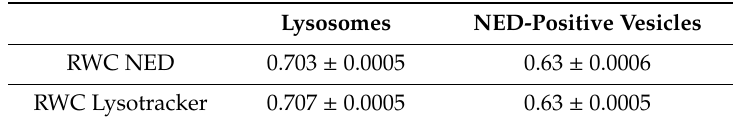
Figure 2. Live-cell imaging of cis -NED 19 localization in rat aorta smooth muscle cells. A —ER tracker; A’ — cis -NED 19; A” —merged. B —Mitotracker; B’ — cis -NED 19; B” —merged. C —WGA (plasma membrane traicer); C’ — cis -NED 19; C” —merged. D —Lysotracker; D’ — cis -NED-19; C” —merged. Scale—25 µ m in A , B , and D , and 5 µ m in C . Rank Weighted Colocalization (RWC) coe ffi cients for cis-NED 19 and Lysotracker fluorescent